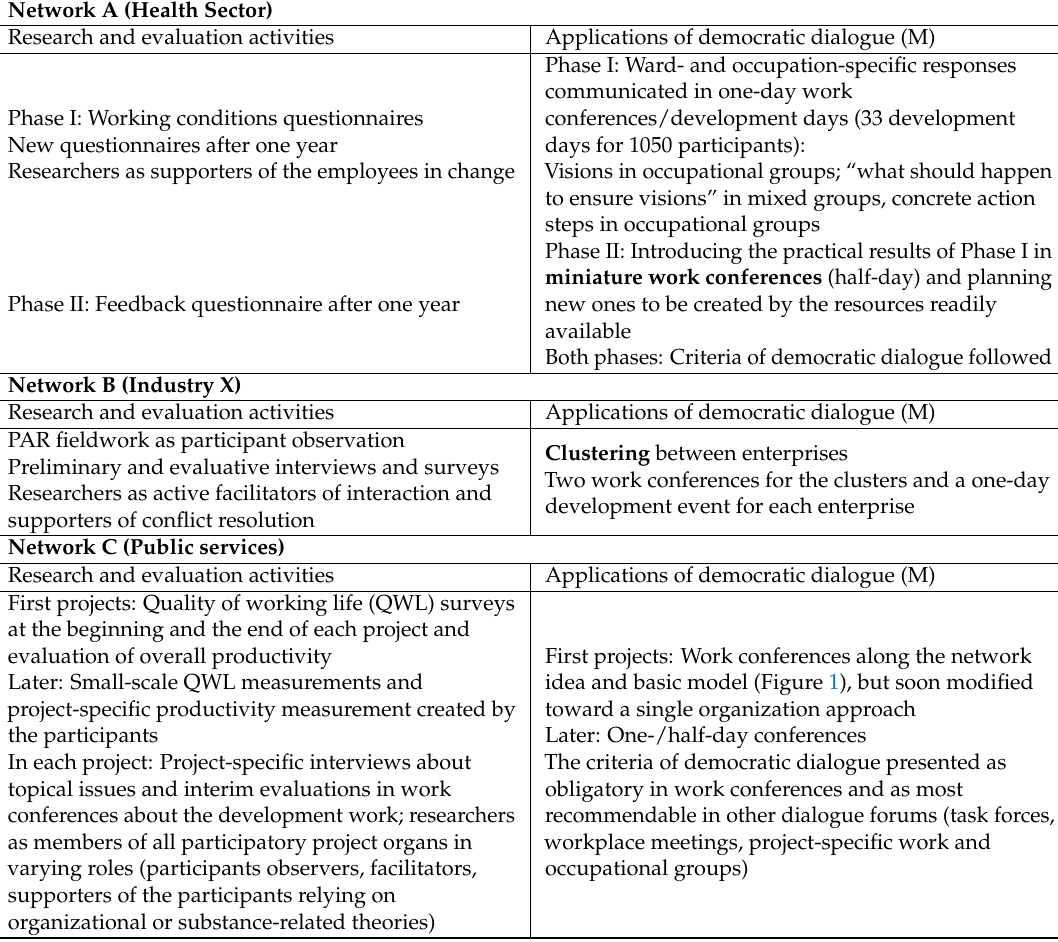
Table 3. The Democratic Dialogue applications and other research work in the